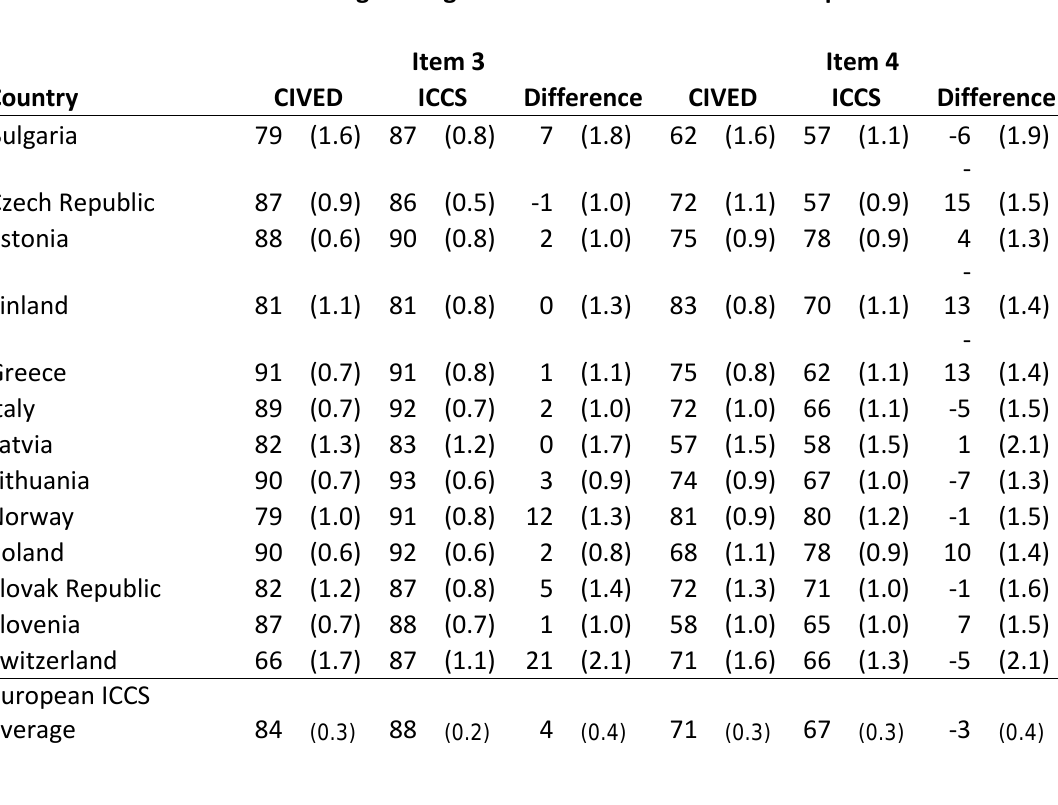
Percentages of agreement for item 3 and 4 in comparison Item 3 Item